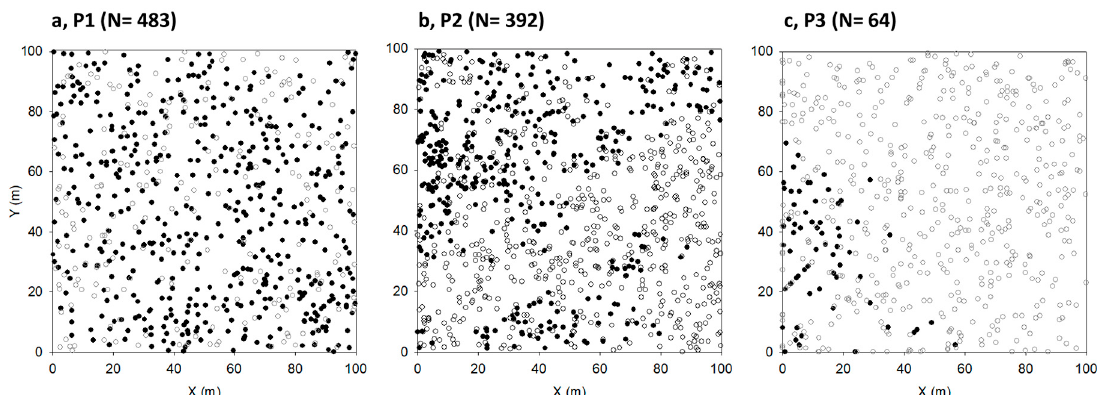
Figure 2. Maps of tree individuals in three study plots P1 ( a ), P2 ( b ) and P3 ( c ). Black circles are S. macrophyllus and white circles are other species. N: number of Streblus macrophyllus individuals.